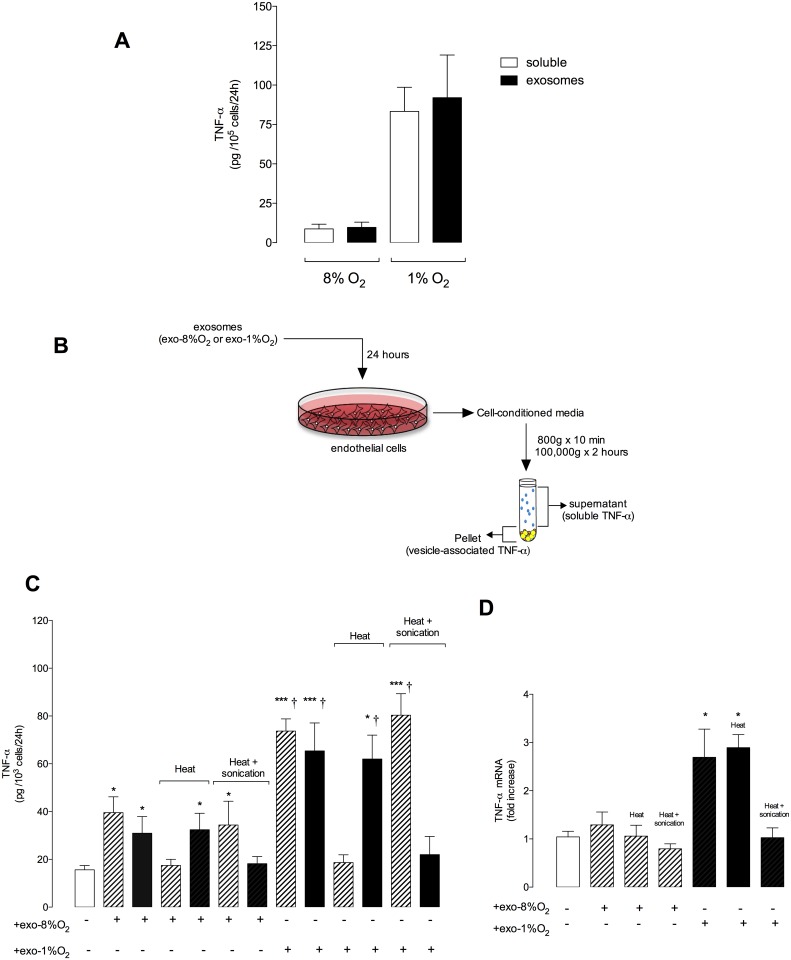
Levels of TNFα in exosome and cell-conditioned media.The concentration of TNFα was quantified in exososomes and EC-consitioned media using an ELISA kit. (A) Exosomes were isolated from EVT cells cultured at 8% and 1% oxygen and the concentration of TNFα was quantified in exosomes and in the soluble fractions (i.e. soluble). The soluble fraction was generated by ultracentrifugation at 100,000g (supernatant). (B) experimental design. (C) EC were cultured in the absence or in the presence of exosomes isolated from EVT culture at 8% or 1% oxygen for 24h and the concentration of TNFα was quantified in EC-derived exosomes and soluble fraction. (D) TNFα mRNA expression. Data represents n = 12 well for each point (6 different experiment in duplicate). Values are mean ± SEM.